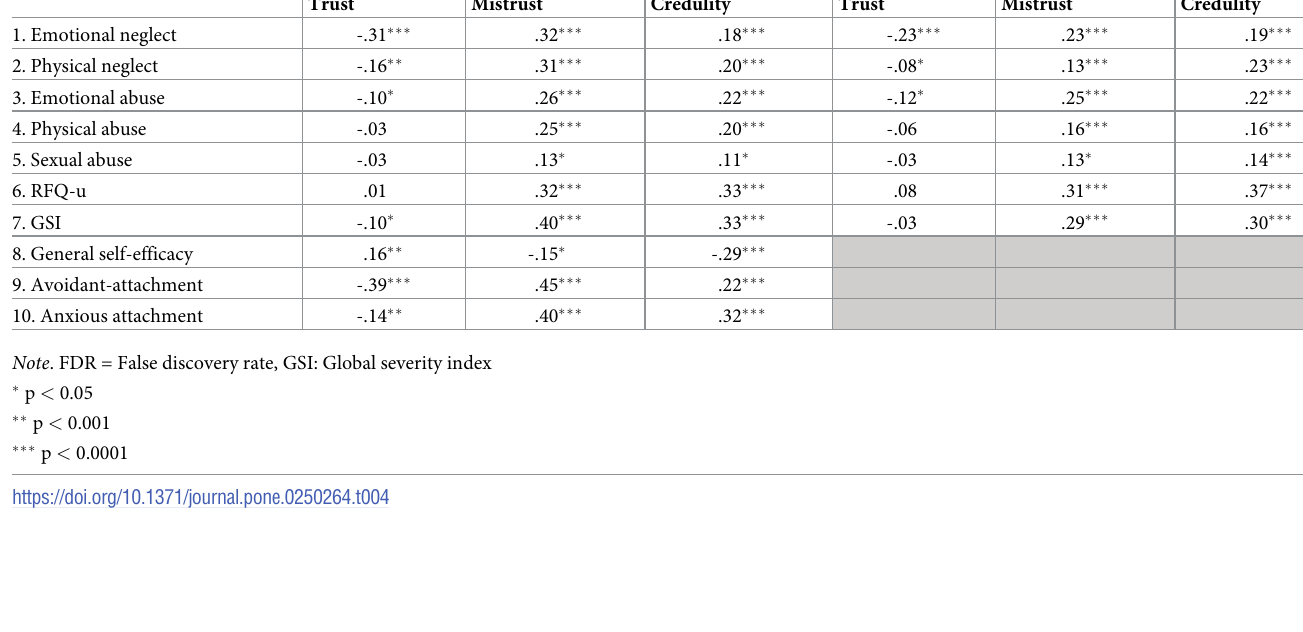
Table 4. Summary of Spearman intercorrelations of ETMCQ subscales, childhood trauma, mental health symptoms, mentalizing, attachment and general self-effi- cacy, controlling for gender, age, annual income and level of education (FDR corrected). Study 1 (n =